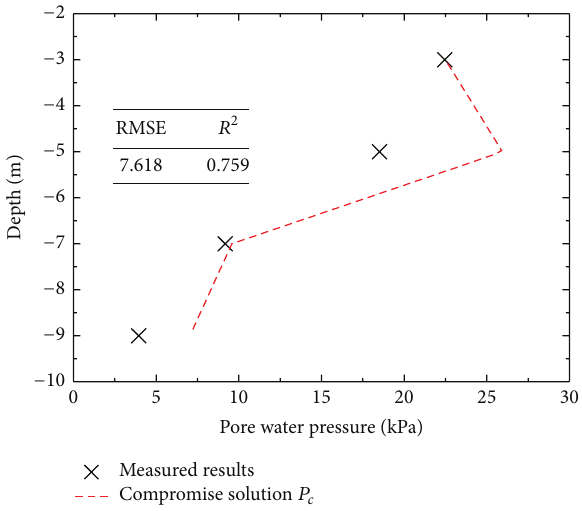
Figure 15: Comparison of measured and predicted lateral displace- ment of ground at impact location A.